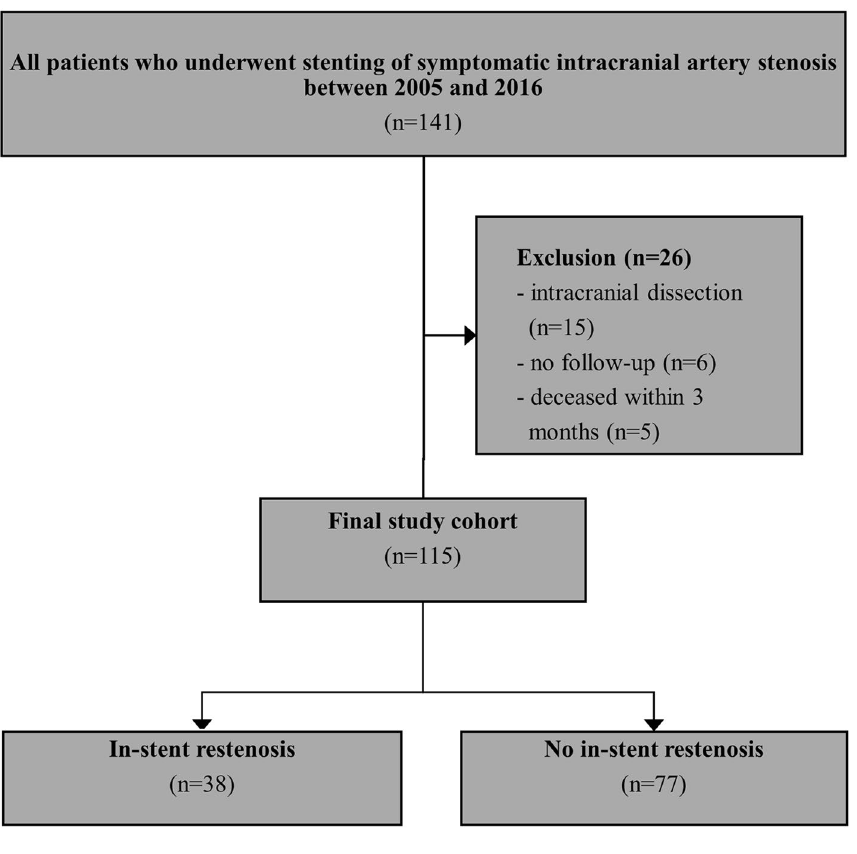
Figure 1. Flow diagram of patient